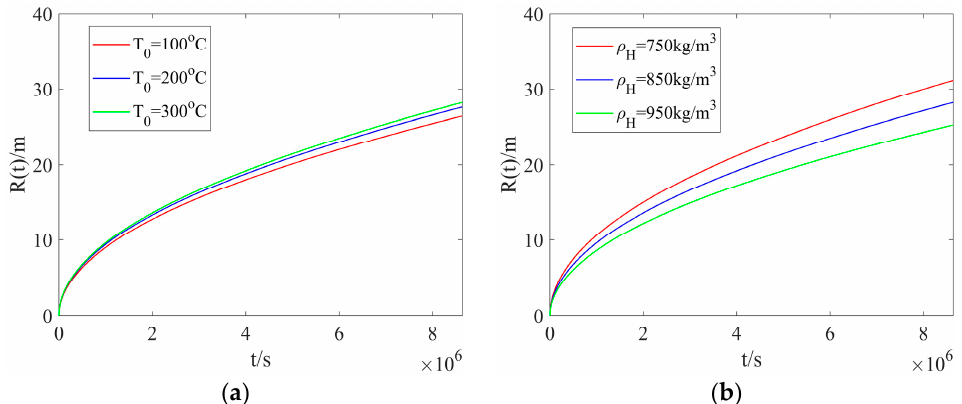
Figure 5. The radial dissociation distance: ( a ) different heated ‐ water temperatures and a fixed hydrate density; ( b ) different hydrate densities and a fixed heated ‐ water temperature.